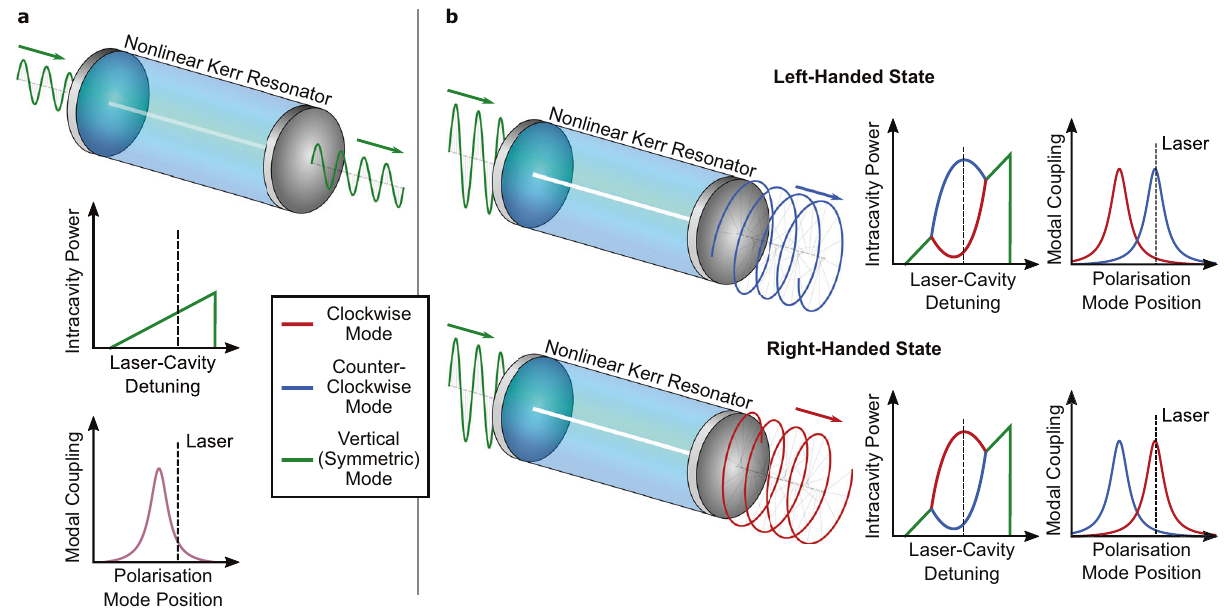
Fig. 1 Kerr interaction of the polarization modes of light. Linearly polarized light enters a nonlinear high-Q Fabry – Pérot cavity with degenerate polarization modes. a Below threshold power, the resonator equally supports all polarization states and the output polarization matches the input. b The linear polarized input light can be described as a superposition of left- and right-circular polarized light. Above a threshold power exists a regime in which the resonator cannot simultaneously support both left- and right-circular polarization modes. This leads to a spontaneous symmetry breaking in which the output develops an angular momentum with random handedness, even though the input light is linear polarized with zero angular momentum (momentum is conserved with the re fl ection of the opposite-handed light). The plots on the right in b show the intracavity power and resonance frequencies of the symmetry broken